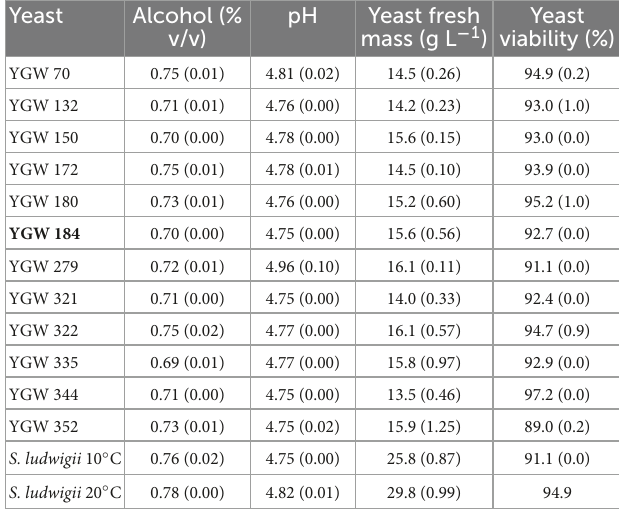
TABLE 2 Alcohol content and pH of Mrakia gelida beers, and yeast fresh mass and yeast viability after fermentation of 7.5 ◦ P wort for 2 weeks at 10 ◦